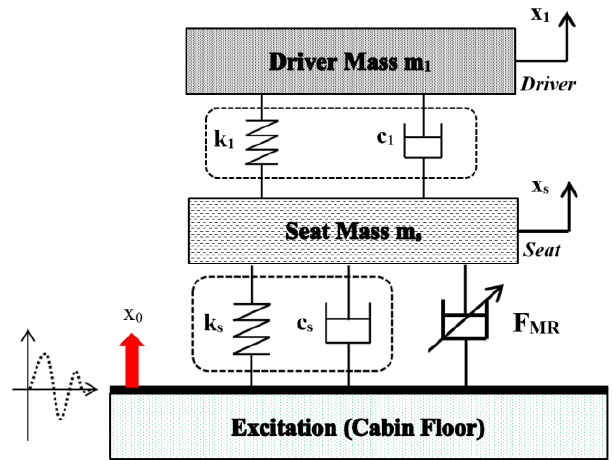
Figure 6. Model of the seat suspension.